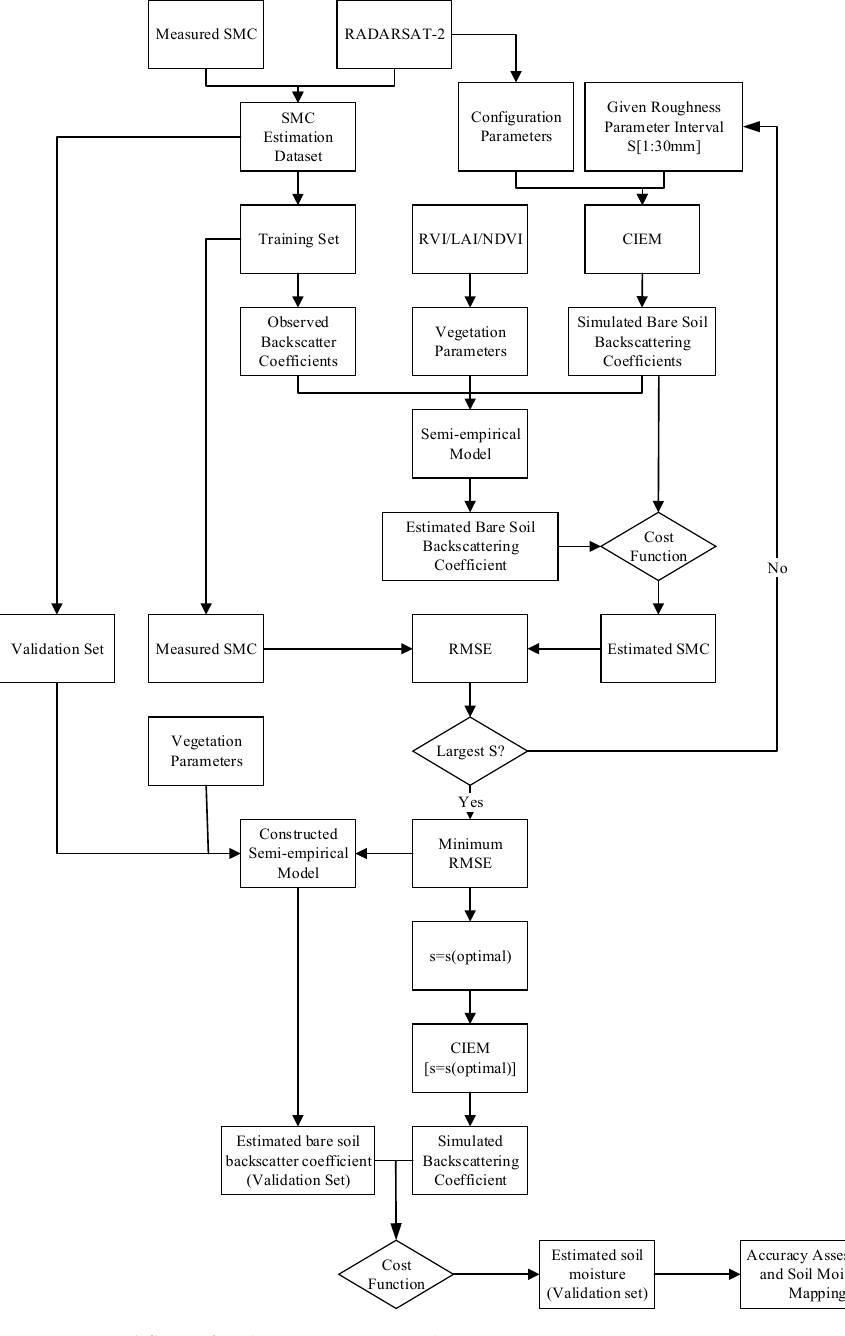
Figure 3. Workflow of soil moisture retrieval.